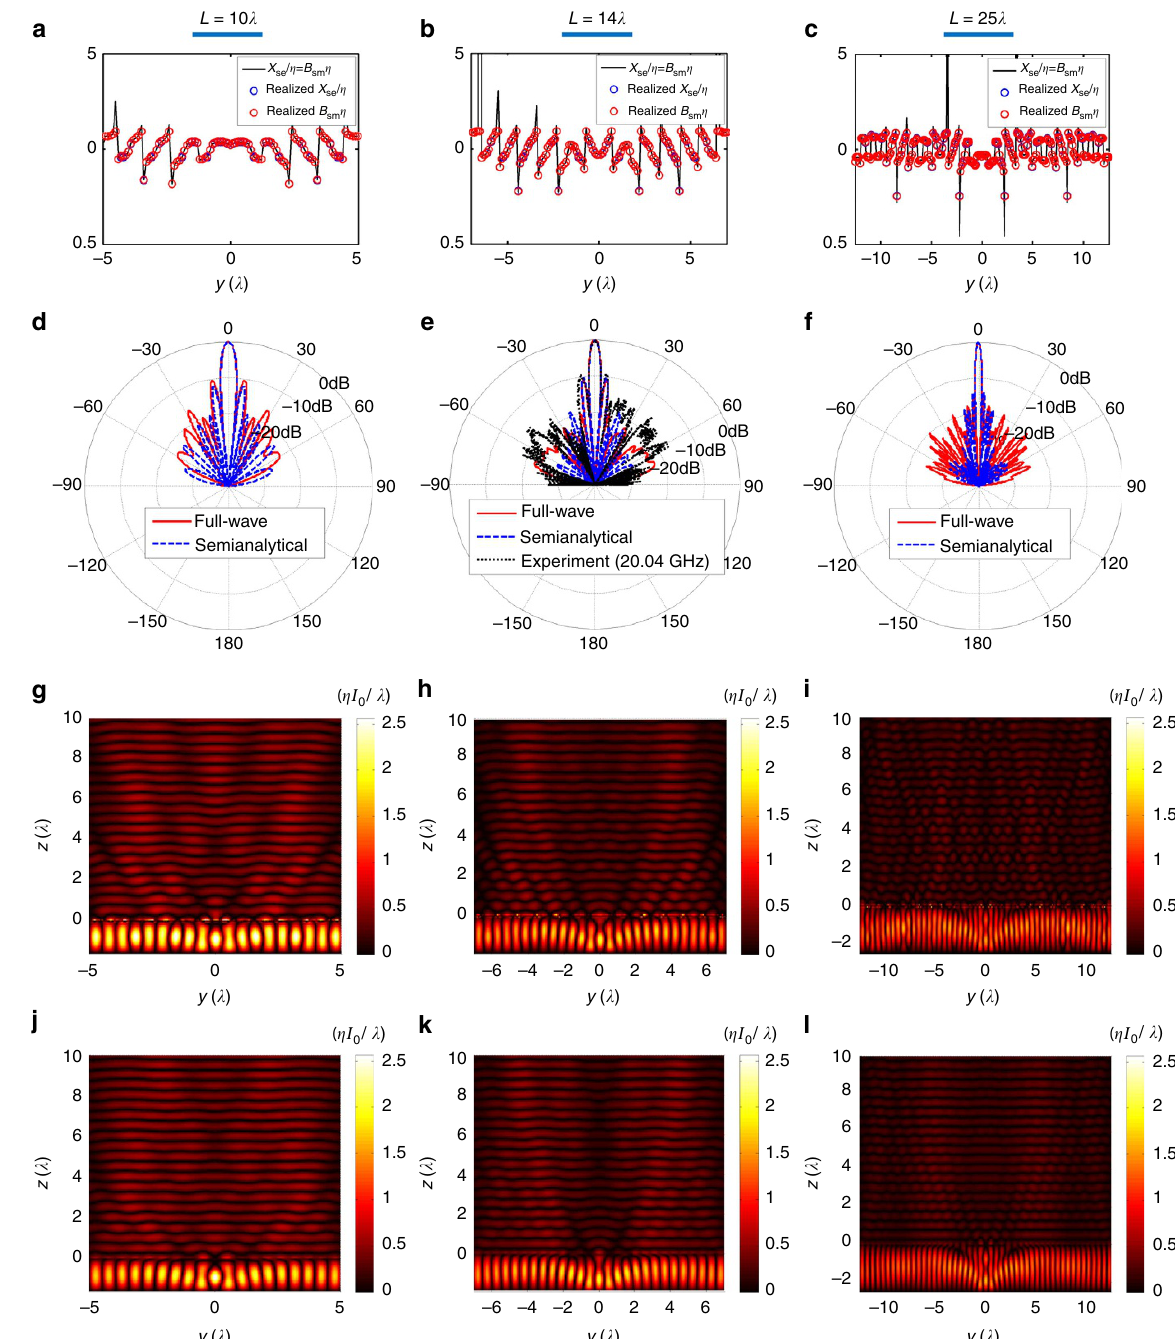
Figure 6 | Performance of cavity-excited HMS antennas. Results are presented for devices with aperture lengths of L ¼ 10 l , L ¼ 14 l , and L ¼ 25 l . ( a – c ) HMS design specifications X se ( y )/ Z ¼ B sm ( y ) Z (black solid line) derived from equation (5), and the realized electric surface reactance (blue circles) and magnetic surface susceptance (red circles) using the spider unit cells. ( d – f ) Radiation patterns produced by semianalytical formalism (blue dashed line) and full-wave simulations (red solid line). For L ¼ 14 l , the experimentally obtained radiation pattern is presented in black dotted line. ( g – i ) Field distribution < E x y ; z ð Þf gj j produced by full-wave simulations. ( j – l ) Semianalytical prediction of < E x y ; z ð Þf gj j (ref.